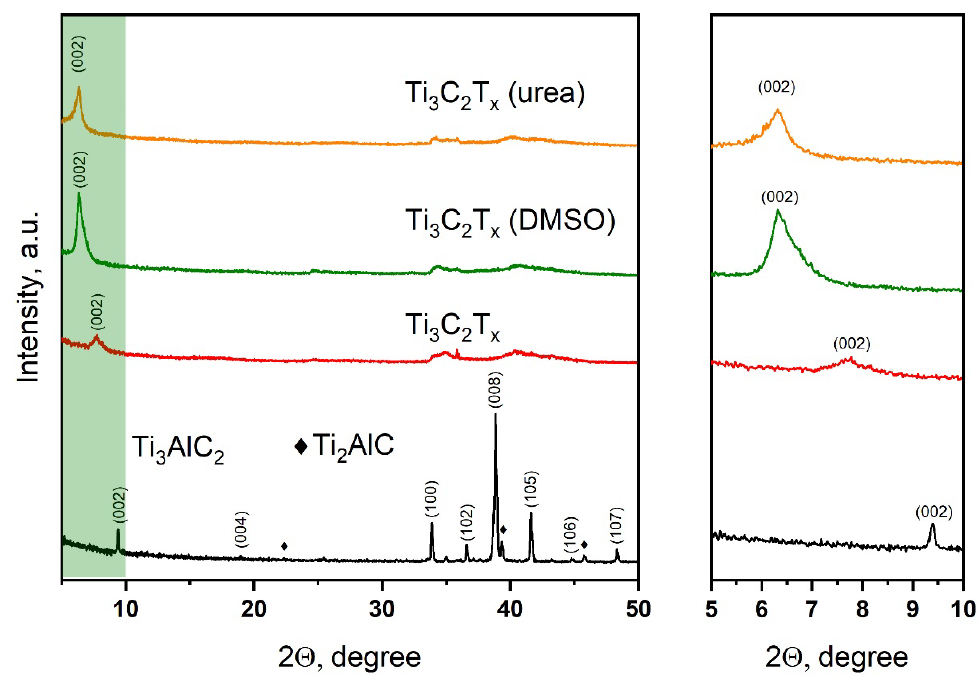
Figure 1. XRD patterns of MAX powder (Ti 3 AlC 2 ), MXene powder (Ti 3 C 2 T x ), and Ti 3 C 2 T x MXene intercalated with DMSO and urea.